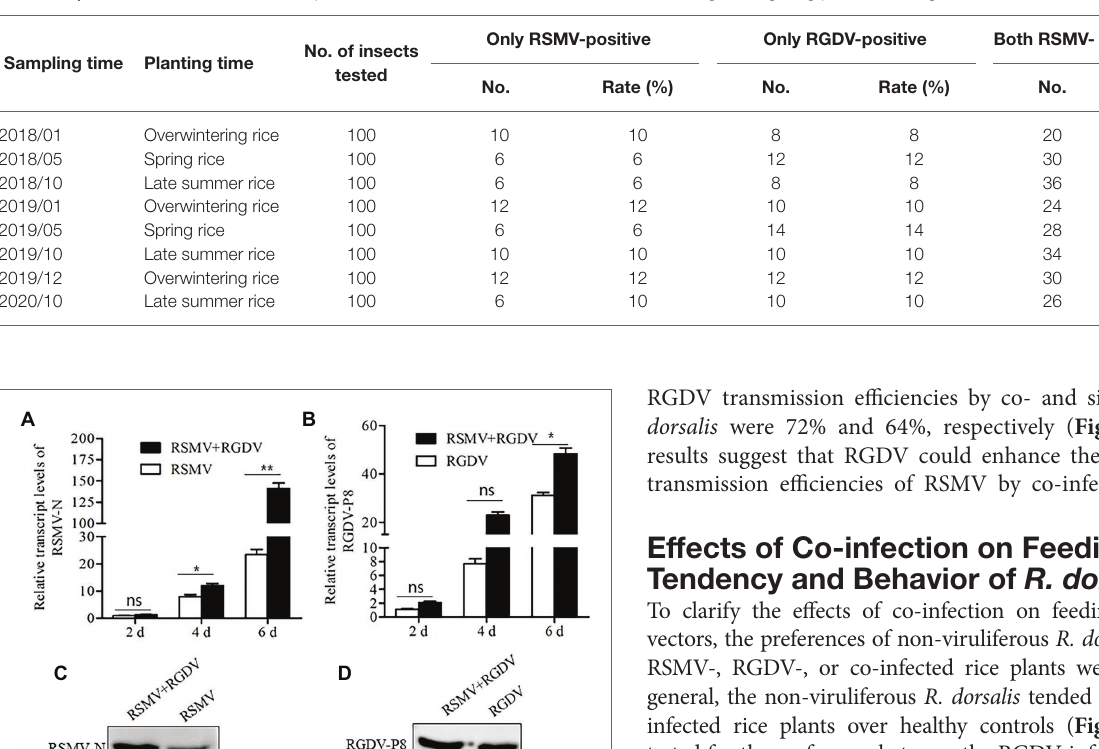
TABLE 2 | The rates of RSMV- or RGDV-positive Recilia dorsalis from diseased field in Luoding, Guangdong province during 2018–2020.